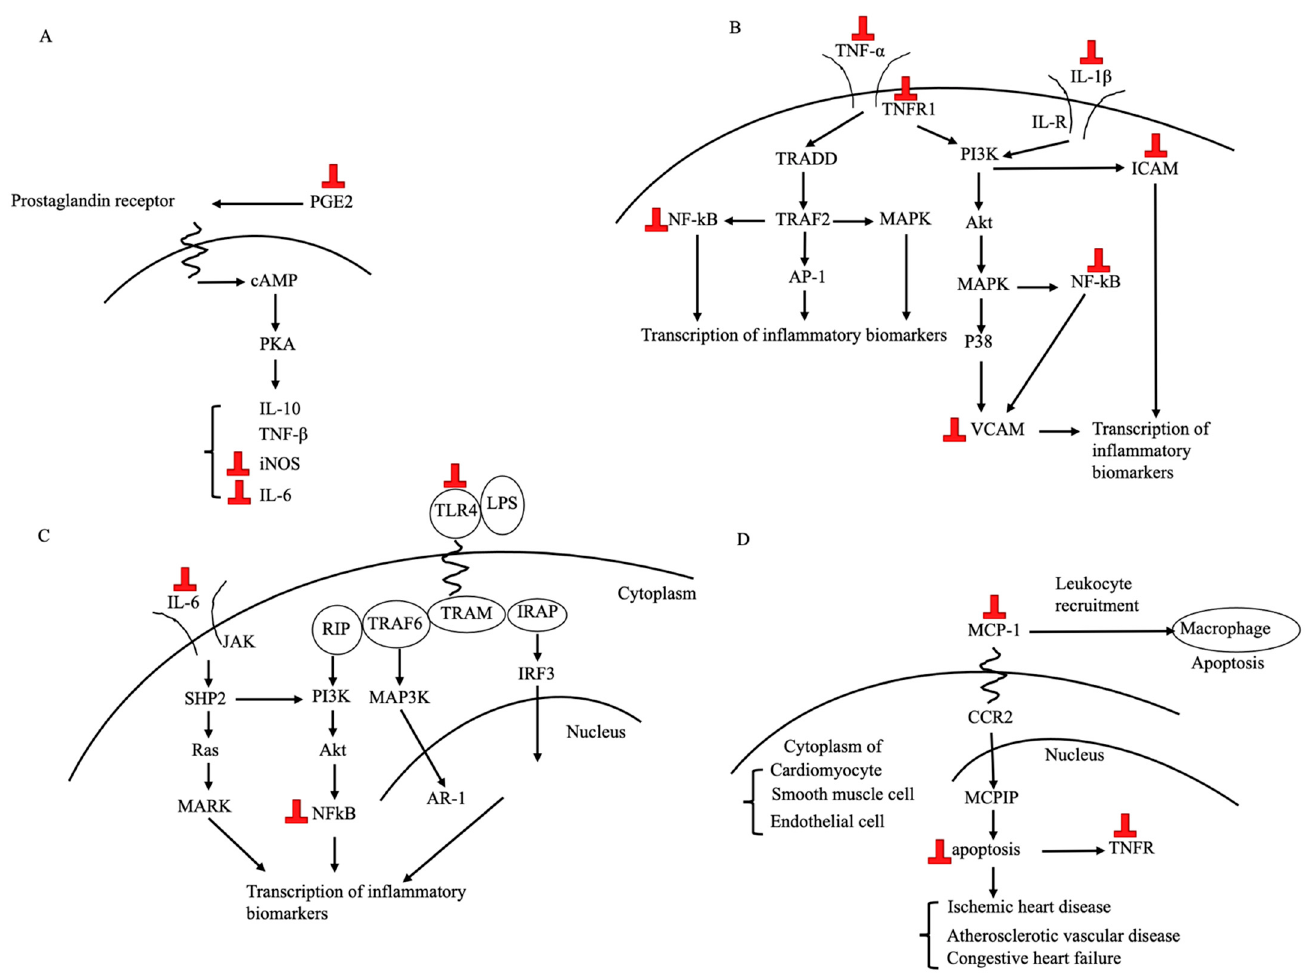
Figure 3. Signaling and pathways in which equol exerts anti-inflammatory effects. ( A ): PGE2 pathway [61]. ( B ): TNF- α [62] and IL-1 pathway [69]. ( C ): TLR4 [65] and IL-6 pathway [69]. ( D ): MCP-1 pathway [64]. “ ⊥ ” indicates the inhibitory effect by equol. PGE2: prostaglandin E2, cAMP: cyclic adenosine monophosphate, PKA: protein kinase A, IL: interleukin, TNF: tumor necrosis factor, iNOS: nitric oxide system, TNFR: TNF receptor, TRADD: TNFR1-associated death domain protein, TRAF2: TNF receptor-associated factor 2, PI3K or Akt: phosphoinositide 3-kinases, MAPK or P38: mitogen-activated protein kinase, AP: activator protein, NF-kB: nuclear factor kappa B, ICAM: intercellular adhesion molecule, VCAM: vascular cell adhesion molecule, IL-R: interleukin receptor, LPS: lipopolysaccharide, TLR: Toll-like receptor, TRIF: Toll/IL-1R domain-containing adaptor-inducing IFN- β , TRAM: TRIF-related adaptor molecule, TRAF: TNFR-associated factor, RIP: receptor-interacting protein, IRF: IFN regulatory factor, IFN: interferon, JAK: janus kinase, SHP: Src homology-2 domain-containing protein tyrosine phosphatase, AR: androgen receptor, MCP: monocyte chemoattractant protein, CCR: Chemokine receptor, MCPIP: monocyte chemoattractant protein-induced